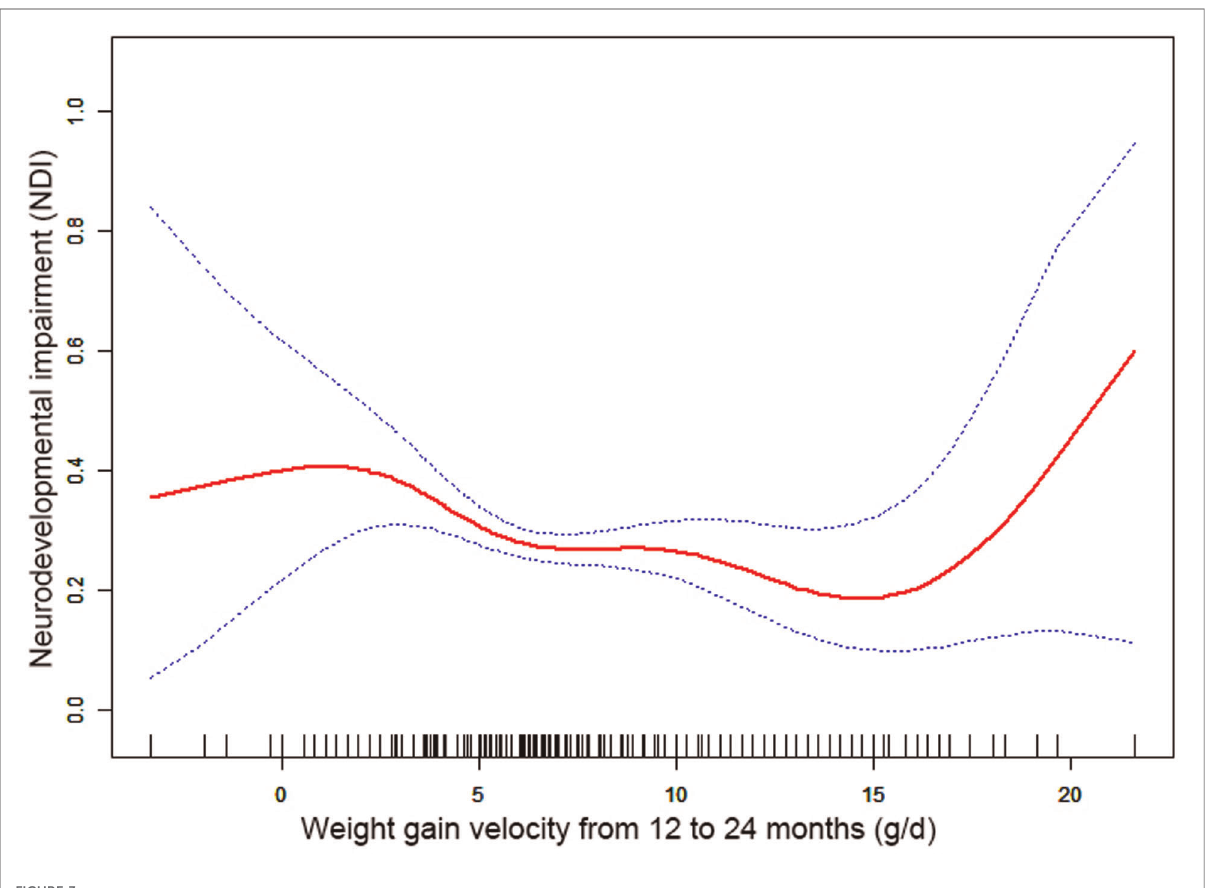
FIGURE 3 Nonlinearity of weight gain velocity from 12 to 24 months CA on neurodevelopmental